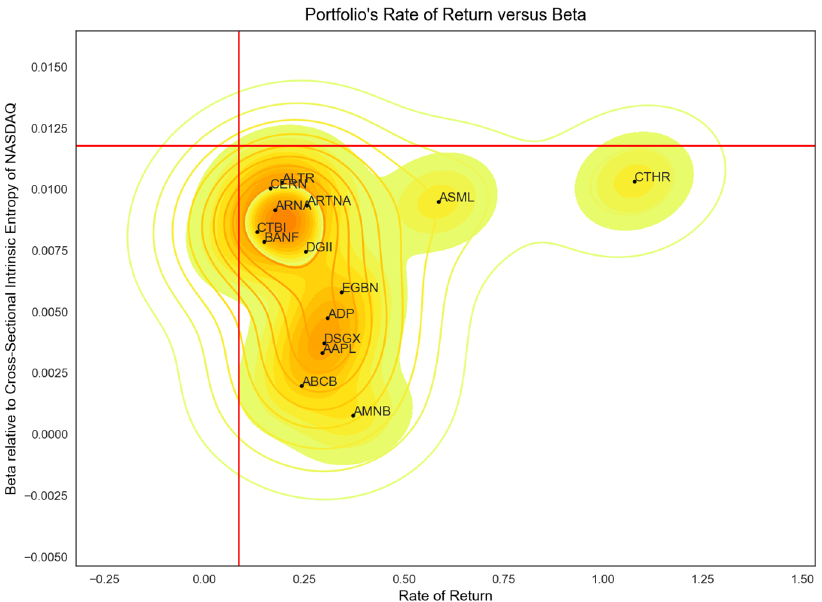
Figure A5. A set of 15 NASDAQ symbols that outperformed the Russell 2000 index in terms of rate of return without being exposed to higher risk (250-day trading interval, from 5 October 2020 to 20 December 2021).